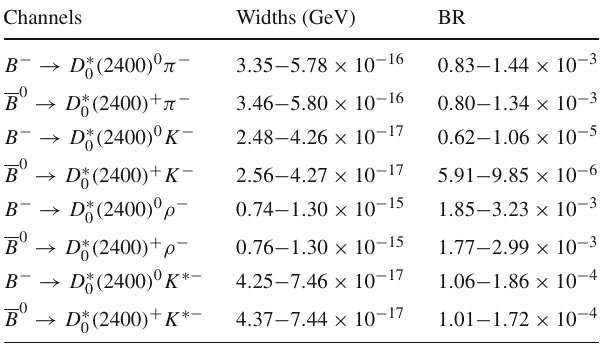
Table 5 Non-leptonic production results of the 1 P state D ∗ Channels